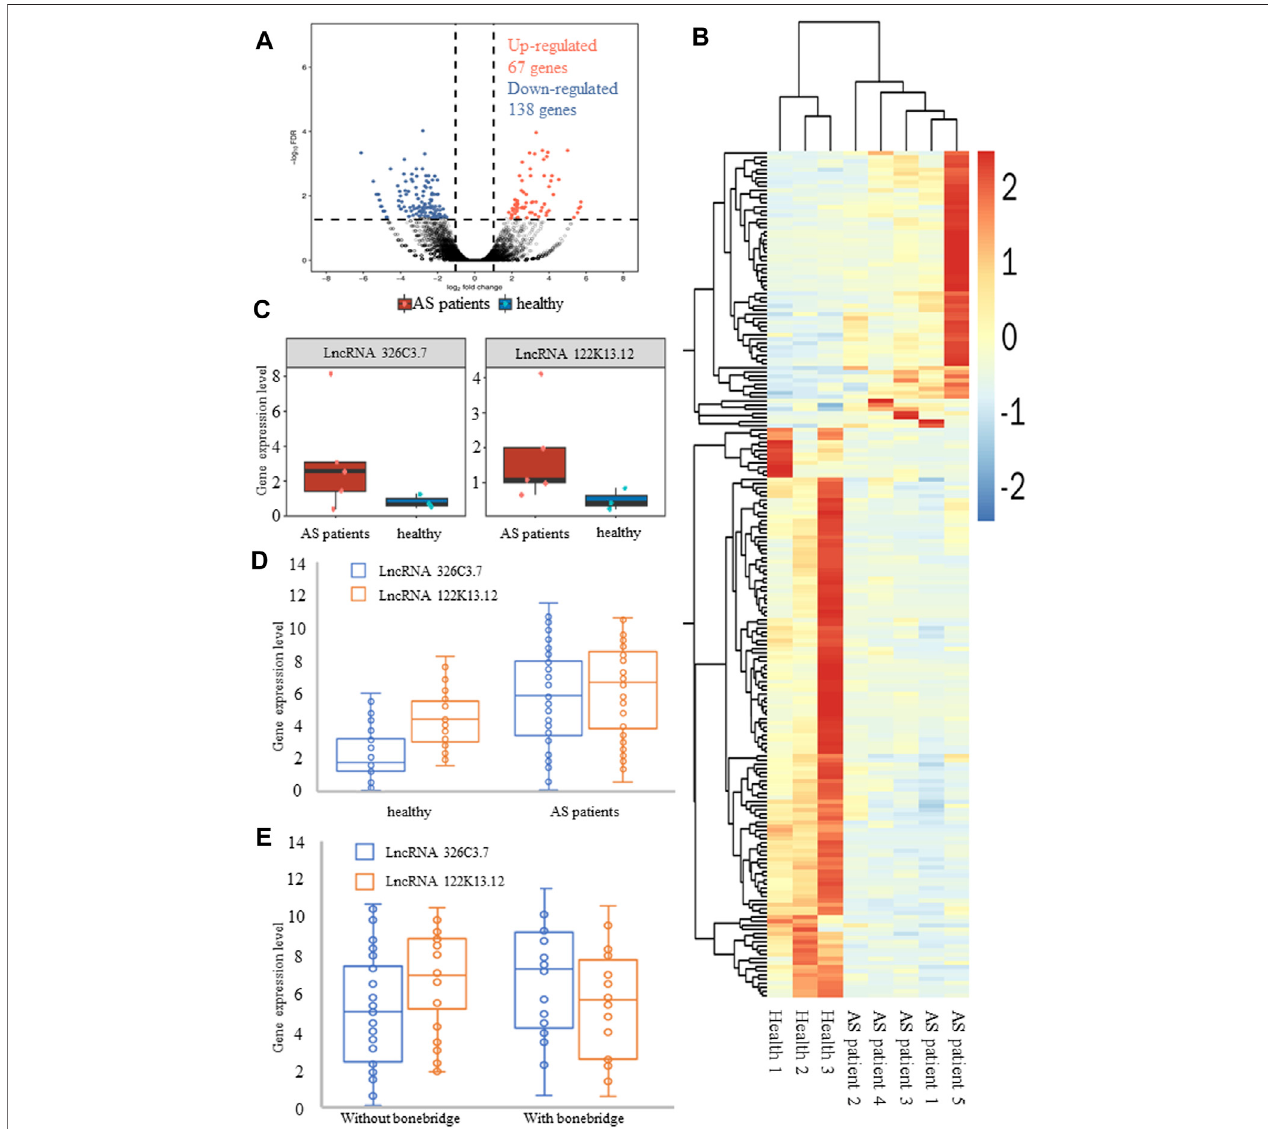
FIGURE2| Differentiallyexpressed genesinnormalgroupsand patients withAS. (A) Volcanoplotofdifferentiallyexpressed lncRNAs. (B) Heatmap ofdifferentially expressed lncRNAs. Blue and red indicate downregulated and upregulated lncRNAs, respectively. (C) RNA-sequencing data showed the expression levels of lncRNA 326C3.7 and lncRNA 122K13.12 in AS patients and healthy people. These two lncRNAs were overexpressed in AS patients. (D, E) Further veri fi cation of gene expression levels by qPCR. Also, two comparisons were made, one between healthy people and AS patients and the other between AS patients with and without bone bridge formation.Theresults, consistent withtheresultsofsequencing, showedthatthese twolncRNAswereactually overexpressed inASpatients,particularly in patients with bone bridge formation.